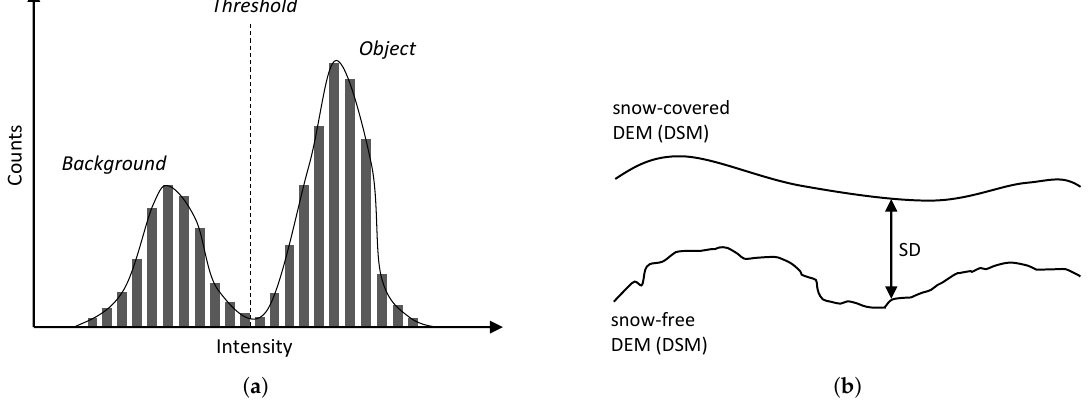
Figure 8. Segmentation by thresholding: a grayscale image histogram and the threshold separating an object and the background ( a ); the snow depth determination principle ( b